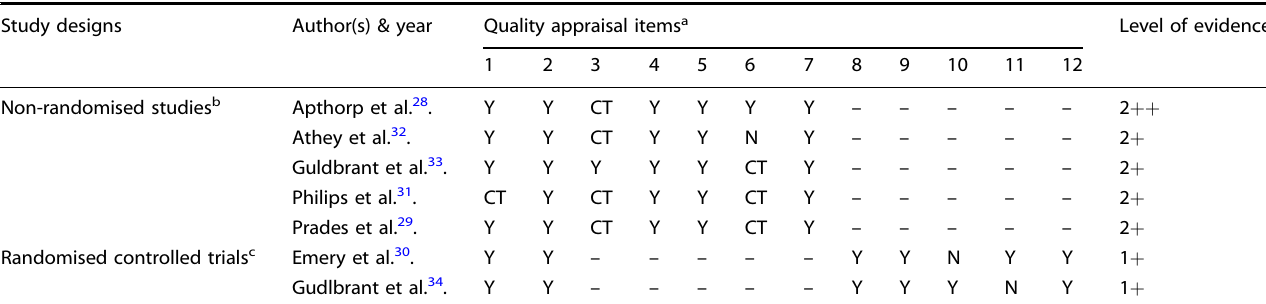
a All studies: 1 = clear research questions/aims 2 = data collected address research question/aims